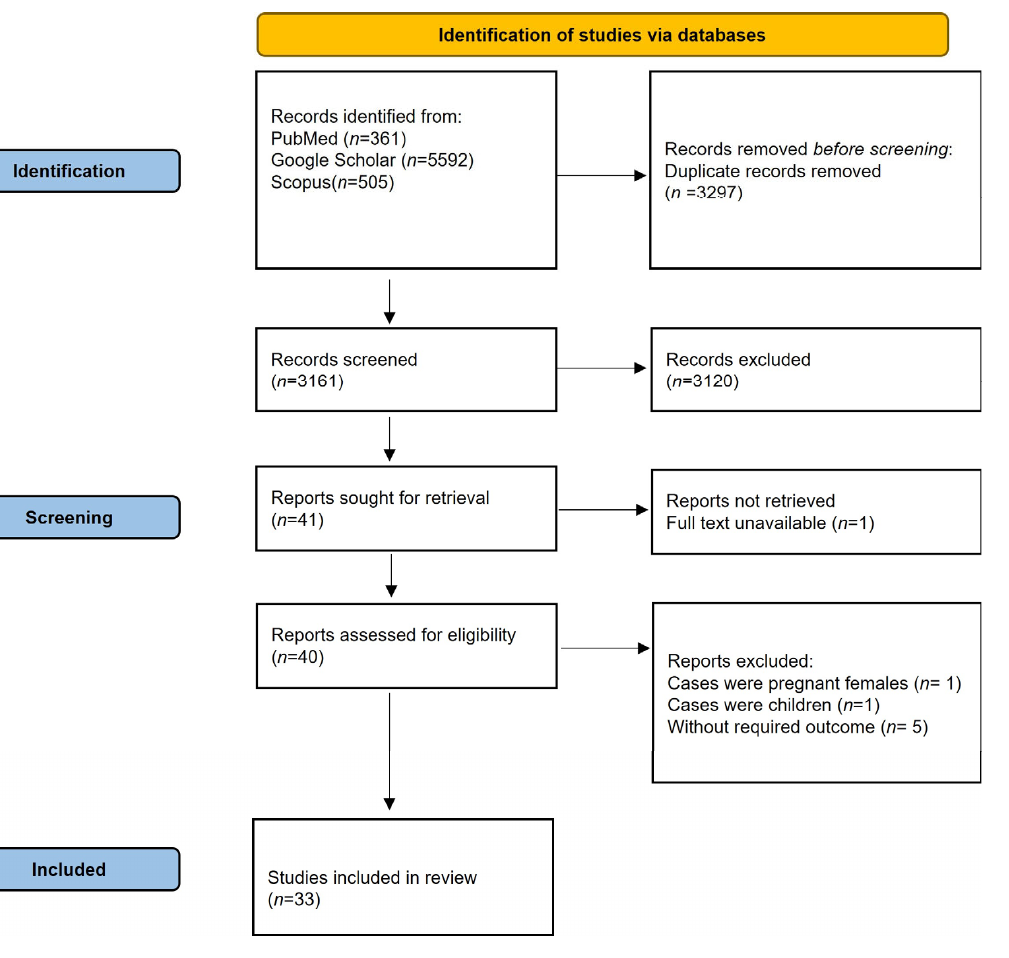
Figure 1. PRISMA 2020 flow diagram of the study selection process.